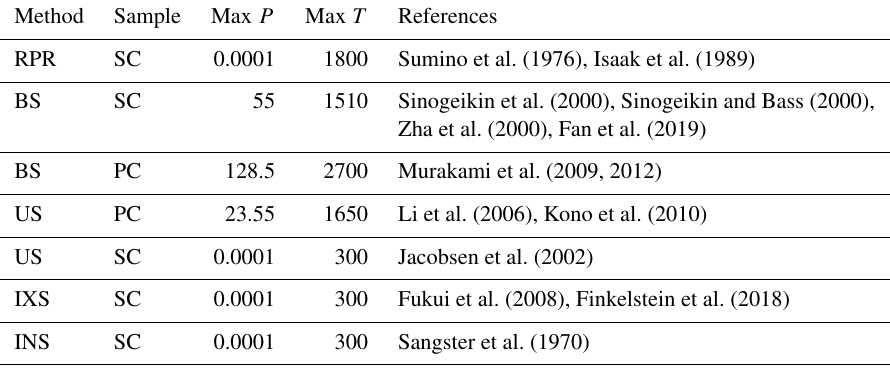
Table A1. Overview of experimental methods.